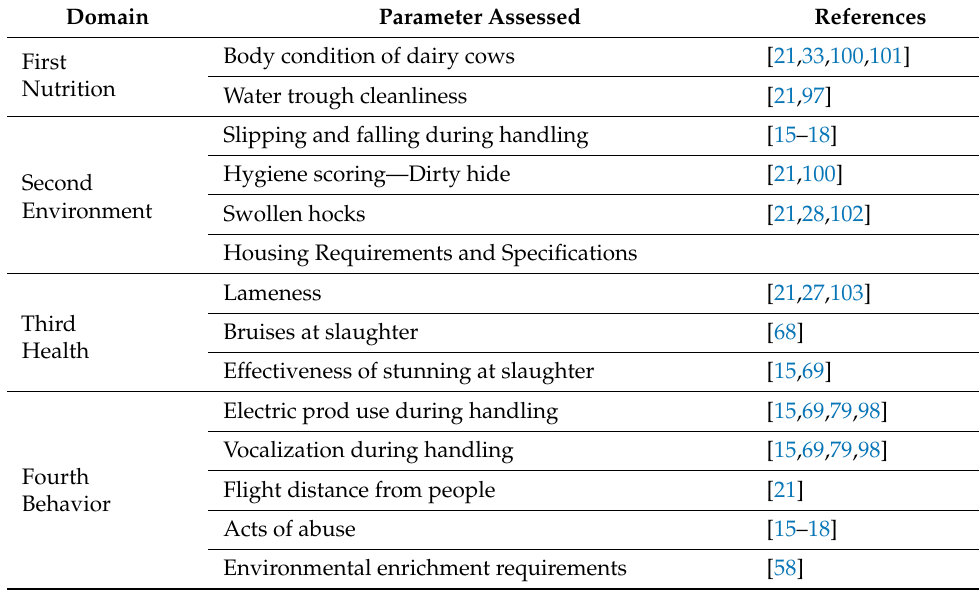
Table 2. Key Welfare Indicators for Dairy